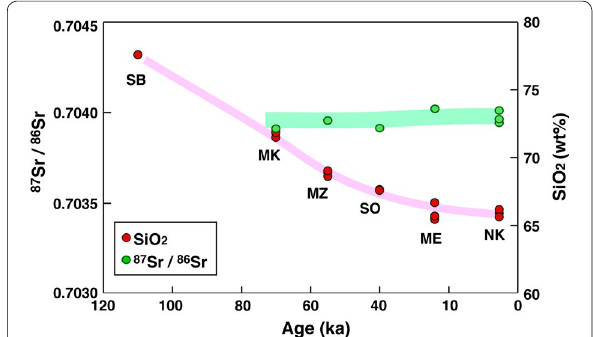
Fig. 6 Temporal variations of SiO 2 (red) and 87 Sr/ 86 Sr (green) in the products of Numazawa Volcano. Abbreviations are same in Fig. 5. Although the SiO